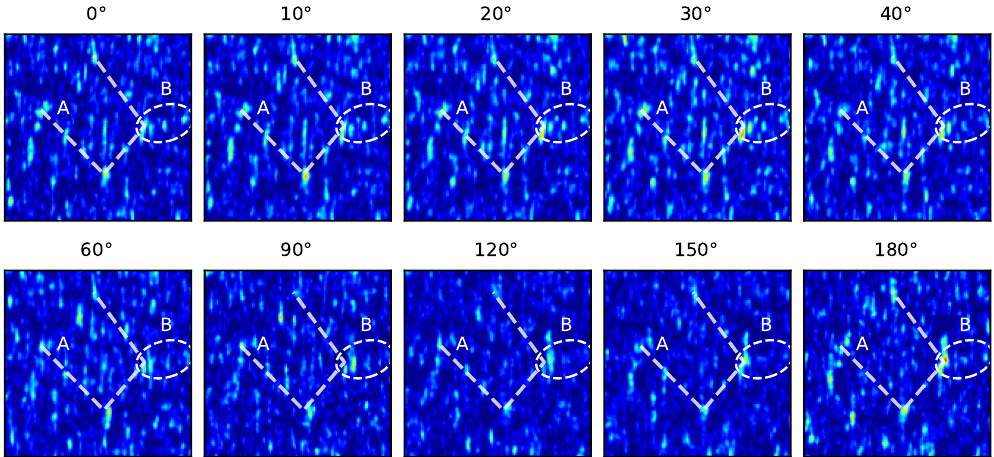
Figure 9. Rotation- and translation-corrected speckle patterns taken from the horizontal milling R z = 2.5 µ m sample at various rotation angles showing the change in the pattern with rotation. Label A (shown by connecting lines) shows a fixed pattern of speckles identifiable throughout, and B (ellipse) shows a group of speckles that appear fade/vanish at higher rotations.